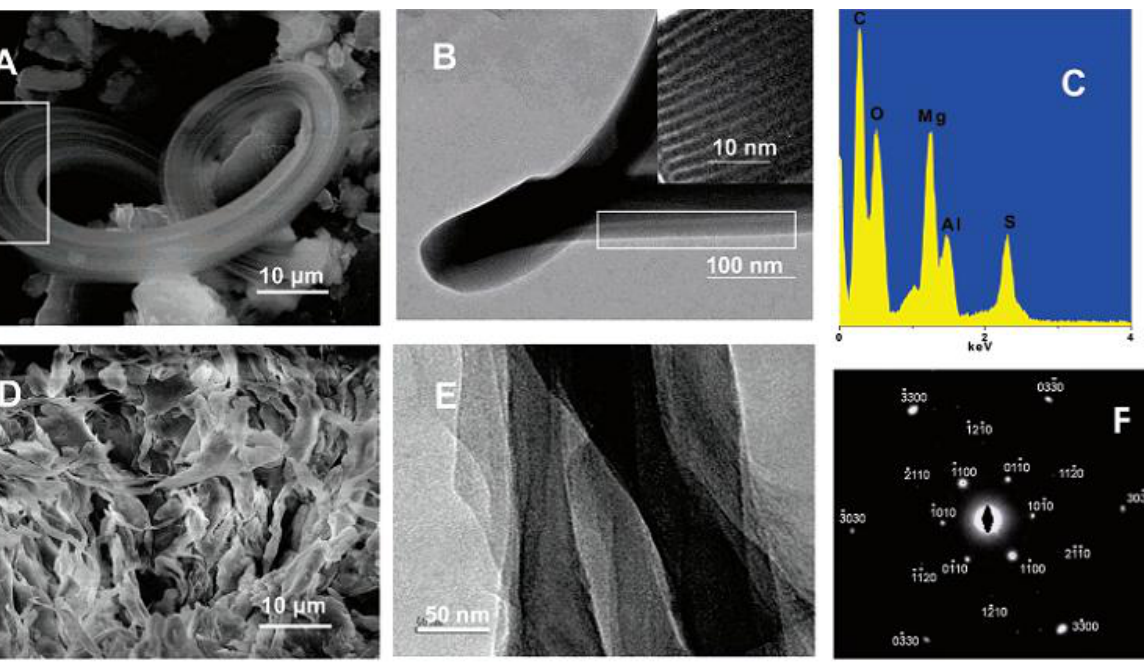
Figure 4. ( A ) SEM image of a belt-like LDH structure with the parallel linear pattern highlighted in the white rectangle. ( B ) TEM image of one belt reveals the lamellar structure; a HRTEM image of this structure is shown in the inset, and ( C ) spectrum of the chemical compositions analyzed by energy dispersive X-ray (EDX). The belts were easily exfoliated to give structures shown by the SEM image in ( D ) and TEM image in ( E ). ( F ) The corresponding selective area electron diffraction pattern. Reprinted with permission from [19], © American Chemical Society,